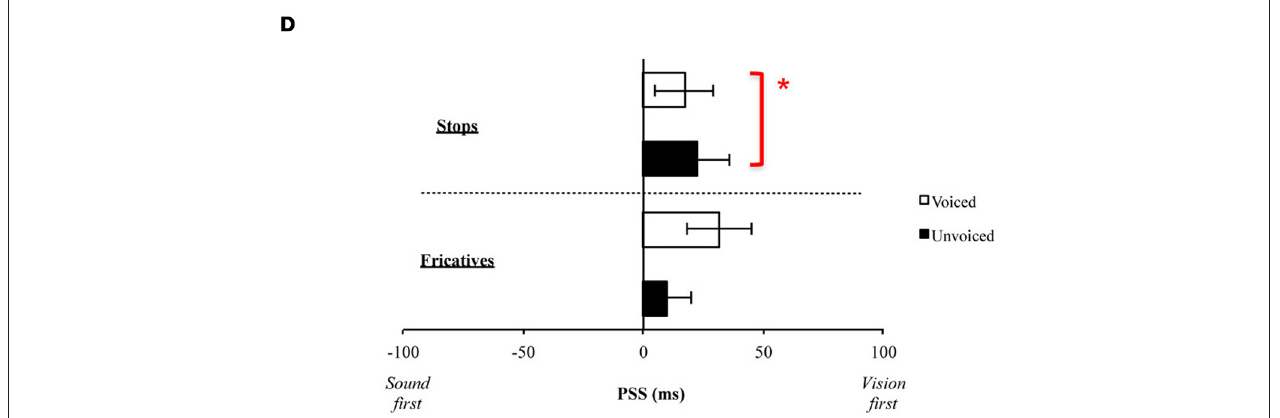
FIGURE 6 | (A) Average JNDs and (B) PSSs for the manner of articulation of the consonant stimuli presented in Experiment 2. The error bars represent the standard errors of the mean. Asterisks indicate significant differences between the various stimuli presented. (C) Average JNDs and (D) PSSs for the voicing of the stimuli presented in Experiment